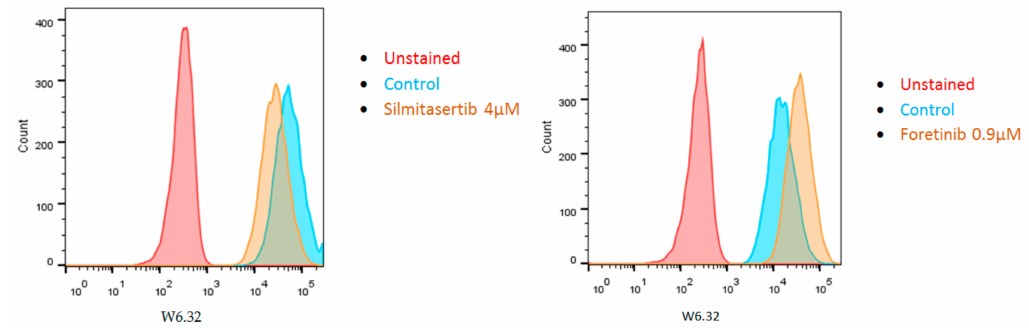
Figure 5. Treatment of cell line OMM2.5 with two di ff erent kinase inhibitors for 48 h either reduced (silmitasertib) or increased (foretinib) HLA Class I expression (monoclonal antibody W6 / 32, measured by Fluorescence-Activated Cell Sorting (FACS) analysis). In the control, no drug was